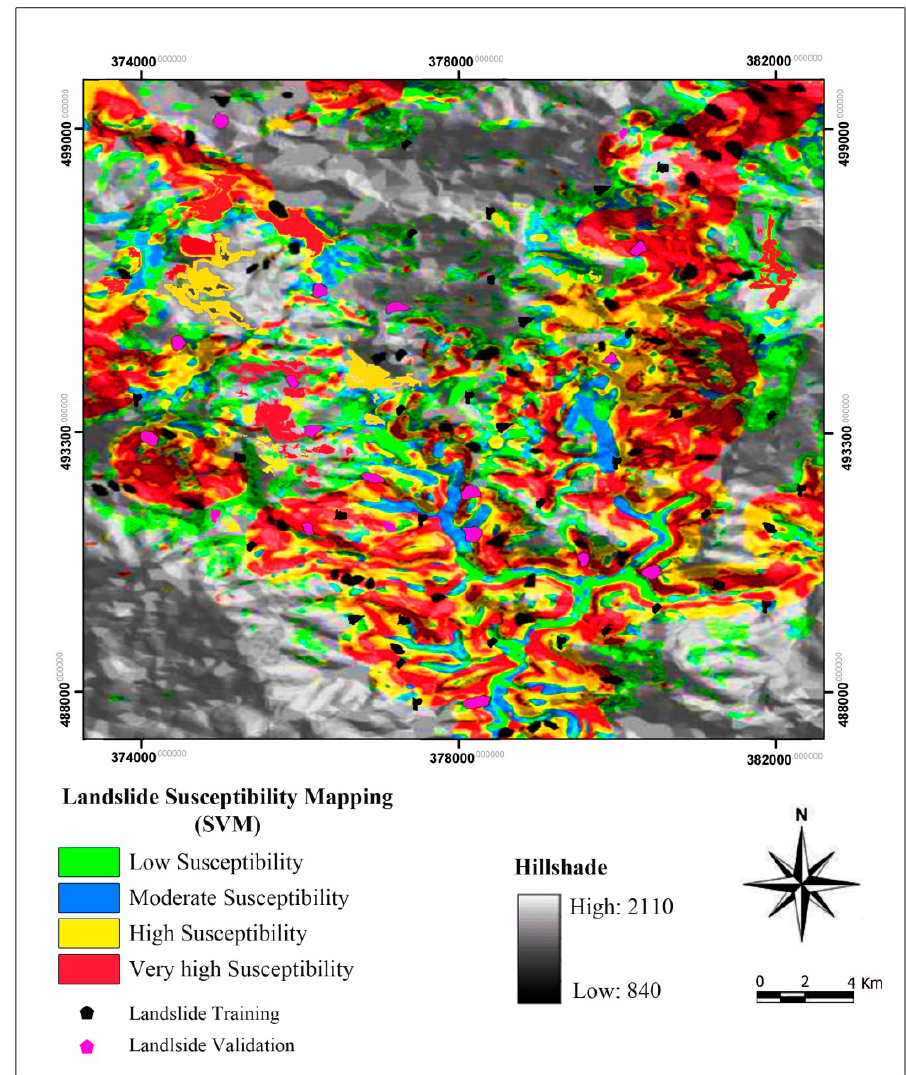
Figure 8. Landslide susceptibility map produced by the SVM model.